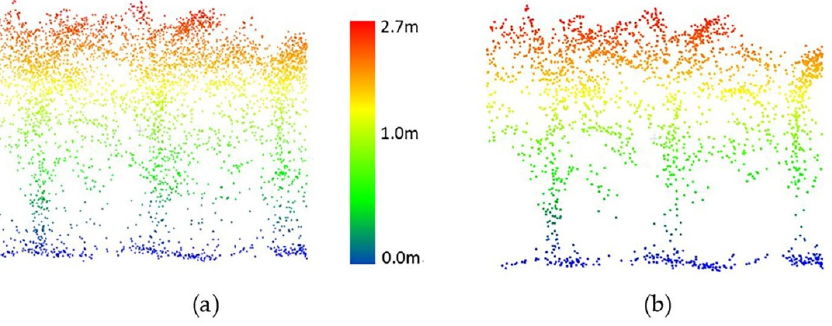
Figure 13. UAV-2 LiDAR data of maize (DAS:60). ( a ) Original data, ( b ) point cloud after outlier removal.